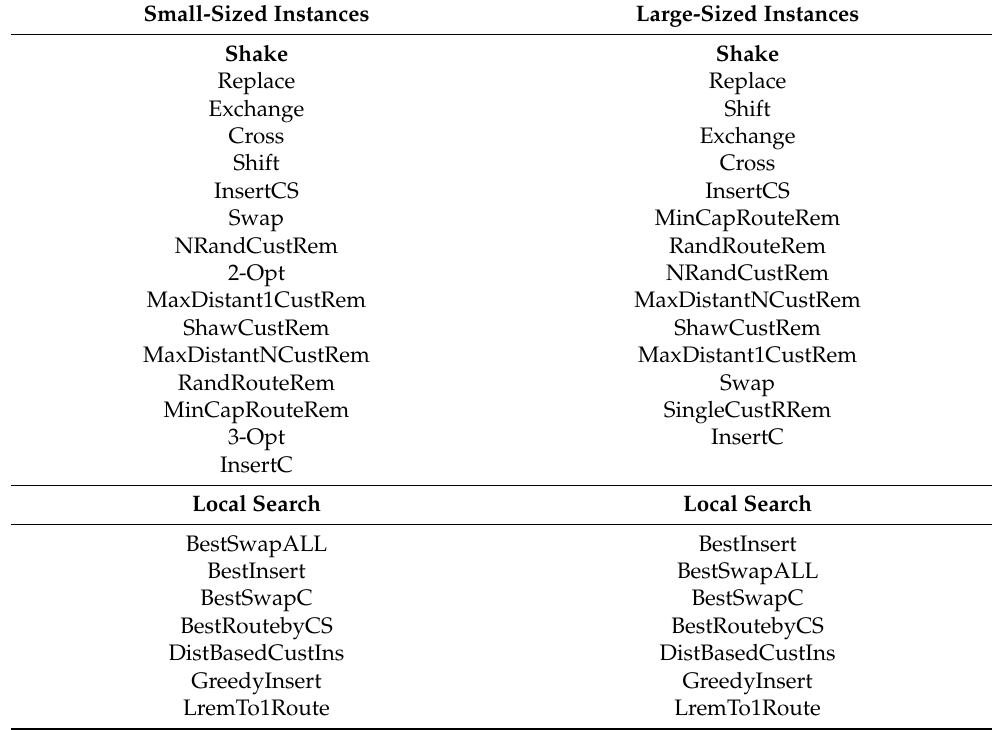
Table 4. Operator sets employed in small-sized and large-sized